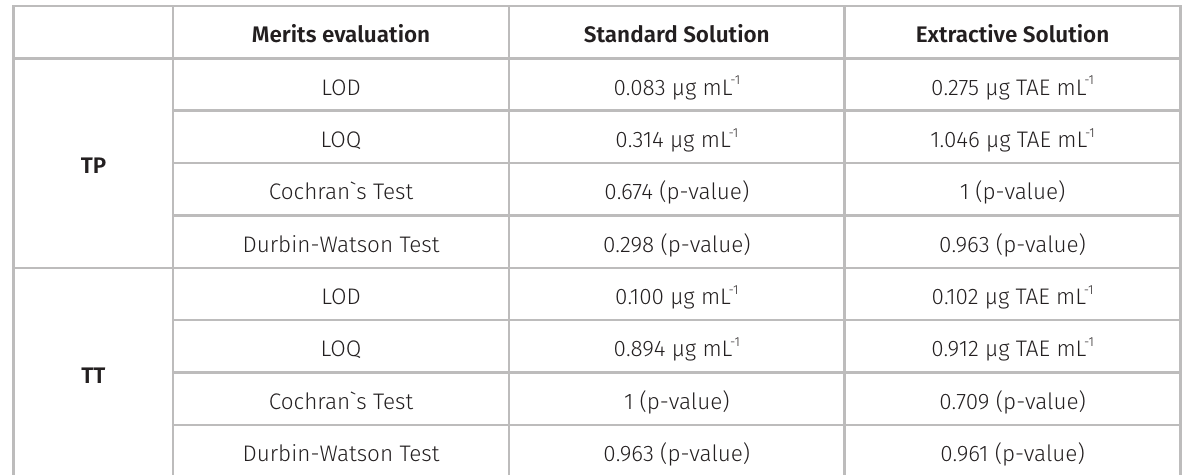
Table II. Linearity results.